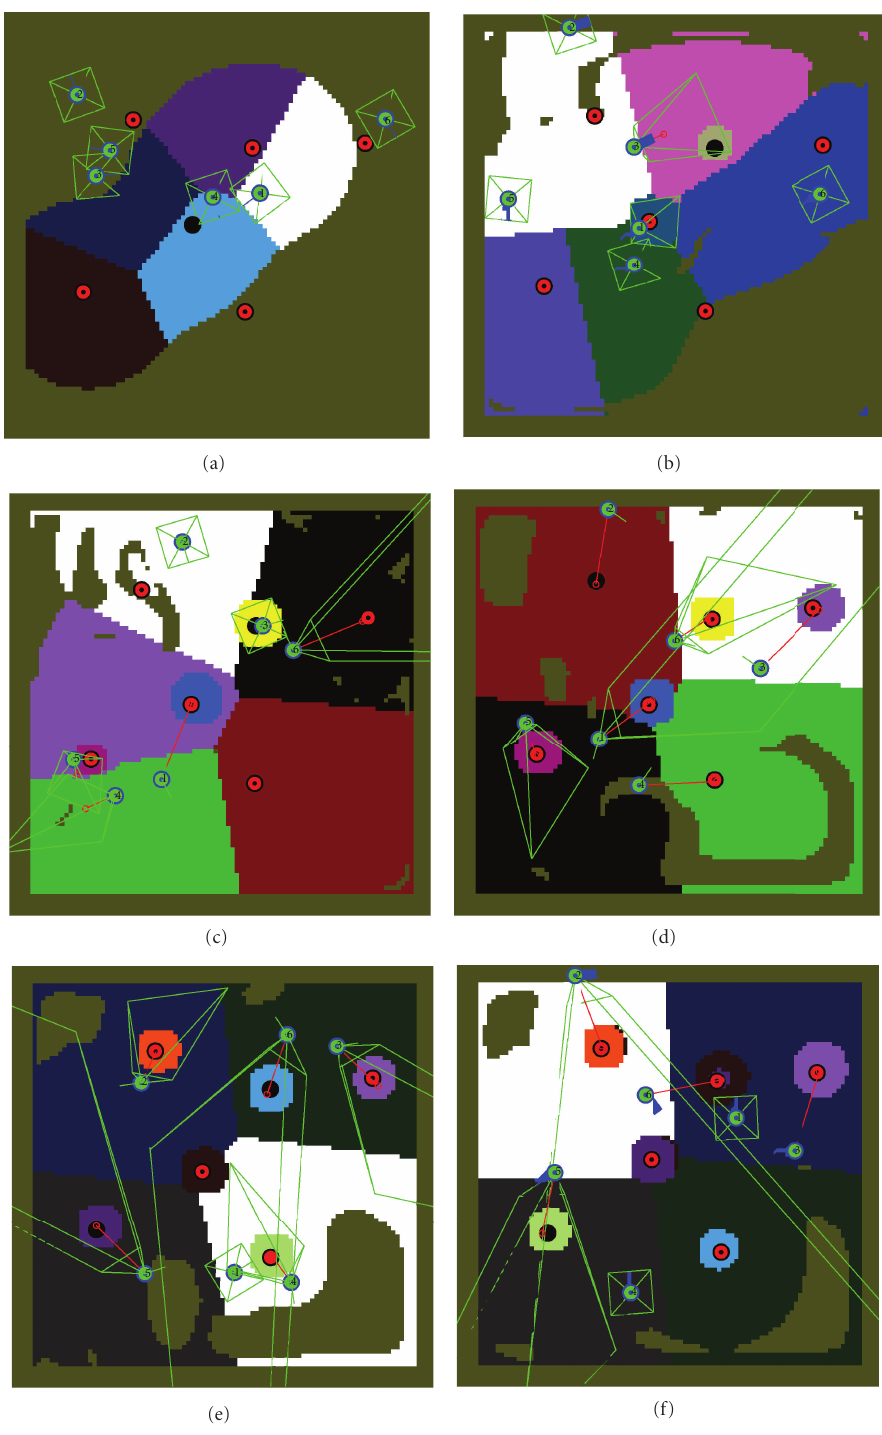
Figure 21: Sample sequence of partition learning classification path planning for a scenario involving six agents and six targets (the number of targets was unknown to the agents). Agents are represented by blue/green circles with protruding lines that represent the direction of the agents. The approximate field of view of each agent is represented by green connected lines. Targets are represented by black/red circles. The entire surveillance area is partitioned. These partitions are represented by di ff erent colors. Follow the sequence from left to right and from top to bottom. In (a) initial partitions are formed. In (b) tracking partitions appear. By (f) all targets are within tracking